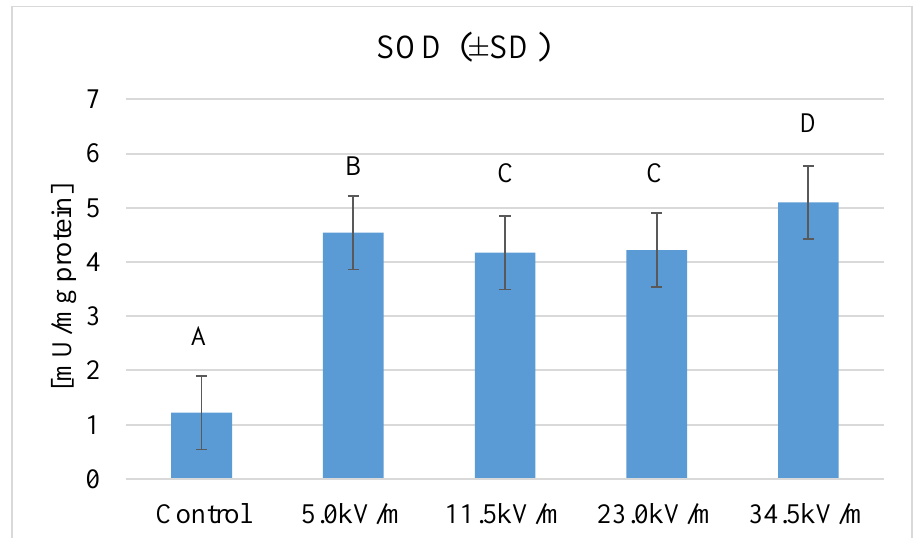
Figure 1. Superoxide dismutase (SOD) activity in honeybee hemolymph after exposure to the E-field (50 Hz and different intensities). The group name is the f E-field intensity. The control group was marked with the letter C. The control groups were not treated to the artificial electromagnetic field, they were under the influence of an electromagnetic field lower than 2.00 kV/m. Statistical differences between the mean values for groups are marked with different letters. Different letters mean the difference is at the p - value ≤ 0.05 significance level.